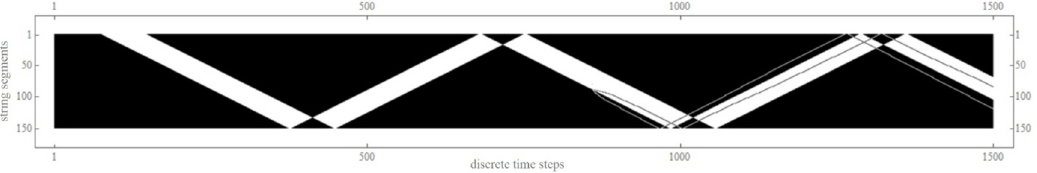
Figure 13 . Local type of the generalized sinh-Gordon equation on the worldsheet. White (black) color indicates that the equation can be reduced to the ordinary sinh-Gordon (cosh-Gordon) equa- tion. The parameters of the simulation are N = 300 , ∆ t = 8 , and (cid:15) = 0 . 095 . After 860 discrete kink time steps, a cusp-anticusp pair emerges.